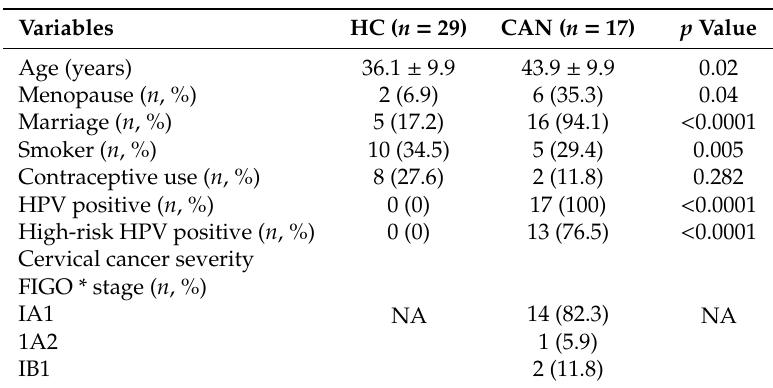
Table 1. Patients’ characteristics.